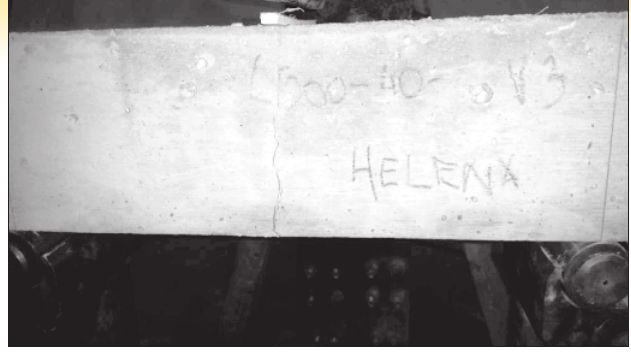
Figure 3. Deflection data were obtained by software directly con - nected to the machine used.